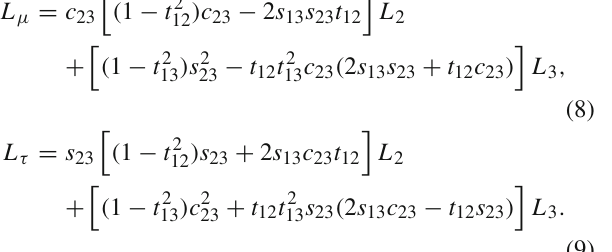
Fig. 2 Comparisons of lepton number asymmetries of both mass eigenstates ( L i ; i = 1 , 2 , 3) and flavor eigenstates ( L α ; α = e ,μ,τ ) for θ = (θ 12 ,θ 13 ,θ 23 ) . Solid/dashed lines are the asymmetries of fla- vor/mass eigenstates. Left and right panels are showing two exam-